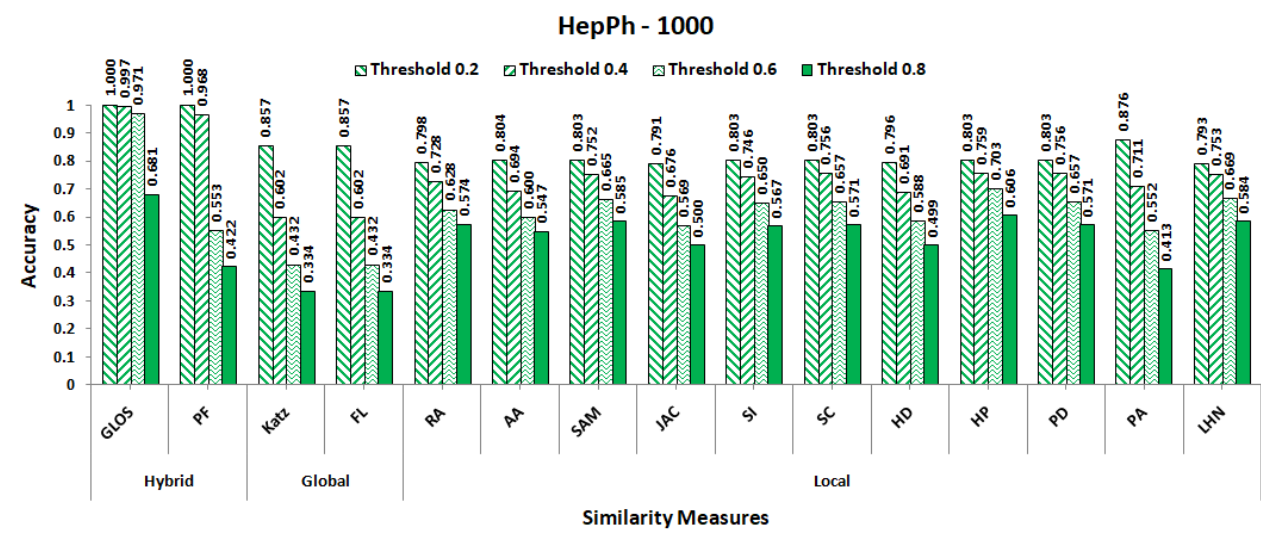
Figure 16. Comparisons of similarity measures on HepPh-1000 edge list from HepPh dataset